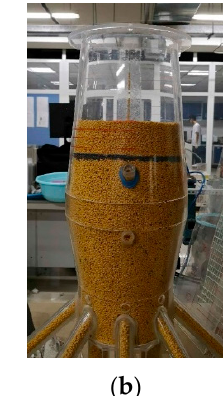
Figure A1. Placing the tracer layer. The view of ( a ) the flat wall and ( b ) the semicircular wall. In the second step, the yellow particles were filled up in the BF body, as shown in Figure A2.